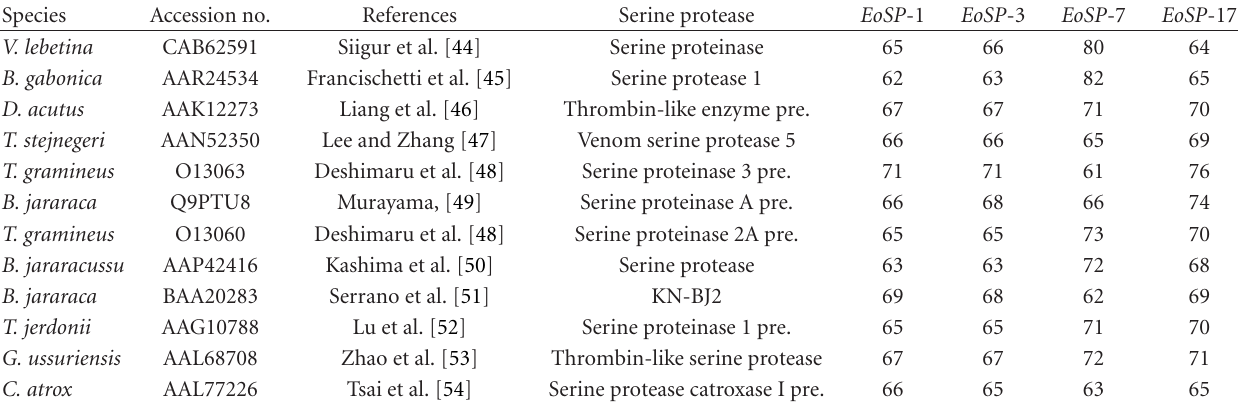
Table 1: Percent sequence similarity between E. ocellatus serine proteases and analogous molecules from related viper species. Species Accession no.